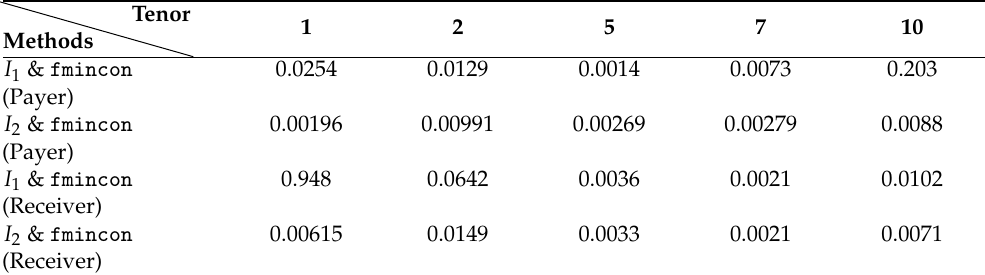
Table 5. Average absolute errors of Monte-Carlo Bermudan swaption prices and Bloomberg’s HW1 Bermudan swaption prices using the I 1 and I 2 as initial points for fmincon .